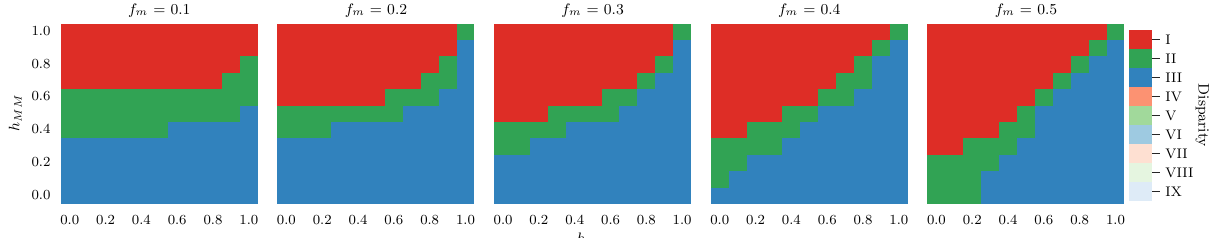
Figure 4. The effects of homophily and fraction of minorities in the global disparity of PageRank. Columns represent the fraction of minorities in the network, x-axis indicates the homophily within minorities, and y-axis the homophily within majoritie s. Colors denote the region where the disparity lies in according to our interpretation in Fig. 2. First, we see that, on average, there is never low global inequality (i.e., regions IV to IX— lighter colors—do not appear). This makes sense because these are scale-free networks. Second, depending on the level o f homophily within groups, minorities on average can be under-represented (region I, red), or over- represented (region III, blue), or well-represented (region II, green). For example, when f m = 0.1 , minorities are on average under-represented when h MM ≥ 0.7 and h MM ≥ h mm